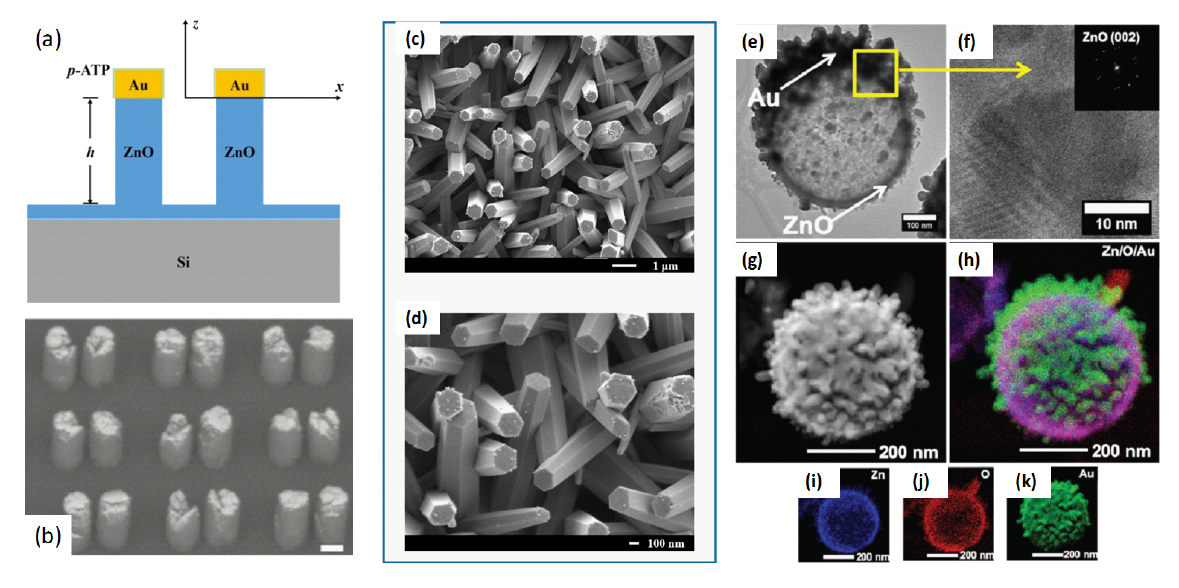
Figure 2: Schematic illustration (a) and SEM (b) of ZnO nanorods obtained by electron-beam lithography and hydrothermal growth with Au nanostruc- tures deposited on their surface. The SEM illustrates ZnO nanorods of 200 nm height, 75 nm Au dimer size and 30 nm gap sizes between the nano- structures. Adapted with permission from [12] Copyright (2018) American Chemical Society. This content is not subject to CC BY 4.0. SEM images (c and d) of Au-decorated ZnO nanorods, where the ZnO nanorods were fabricated using unannealed seed layers and the Au NPs were deposited by pulsed-laser-induced photolysis. Figure 2 (c) and (d) were adapted from [38] (© 2020 Chou, C. M. et al., published by MDPI, distributed under the terms of the Creative Commons Attribution 4.0 International License, https://creativecommons.org/licenses/by/4.0). TEM image (e) of ZnO-Au nano- structures and the high-resolution image (f) of the selected area in (e). STEM (g) and EDX elemental mapping images displaying the ZnO-Au struc- ture (h), Zn (i) and O (j) location in the central part of the nanostructure, respectively Au (k) on its surface. Figure 2 e-k was republished (adapted) with permission of The Royal Society of Chemistry from [16] (“Au-covered hollow urchin-like ZnO nanostructures for surface-enhanced Raman scattering sensing” by O. Graniel et al., J. Mater. Chem. C, vol. 7, issue 47, © The Royal Society of Chemistry 2019; https://doi.org/10.1039/C9TC05929F; permission conveyed through Copyright Clearing Center, Inc.). This content is not subject to CC BY